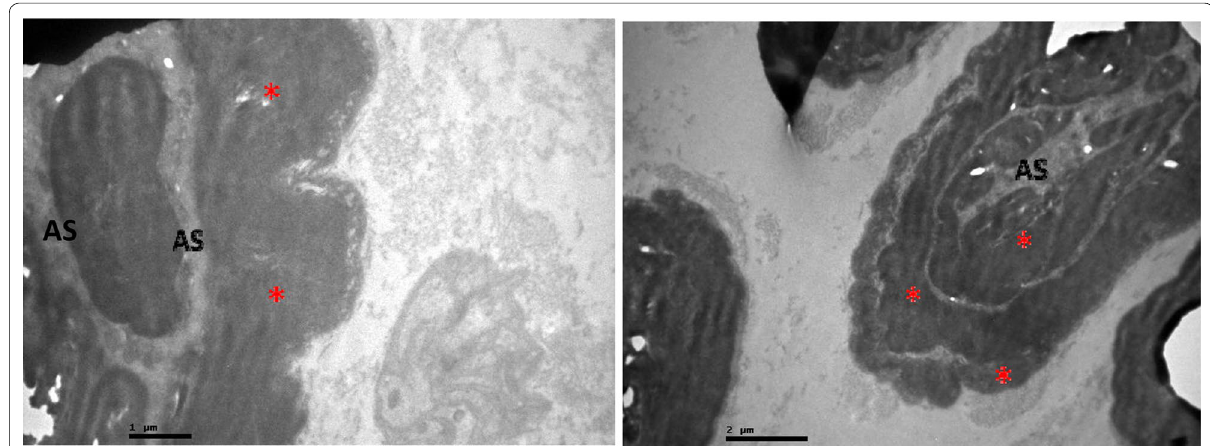
Fig. 3 Effects of alendronate on femoral nerve of research group. Myelin thickening (red asterisk) and αxon strangulation (AS)